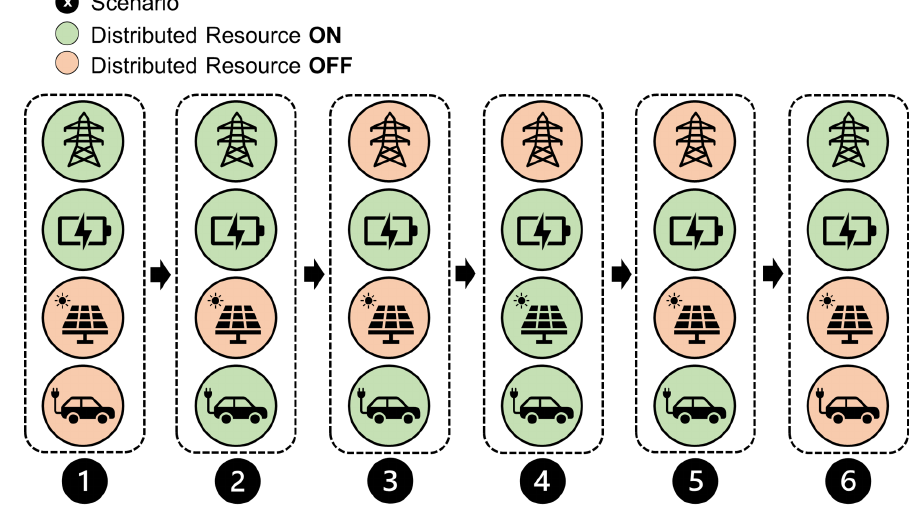
Figure 4. Modes of recharge